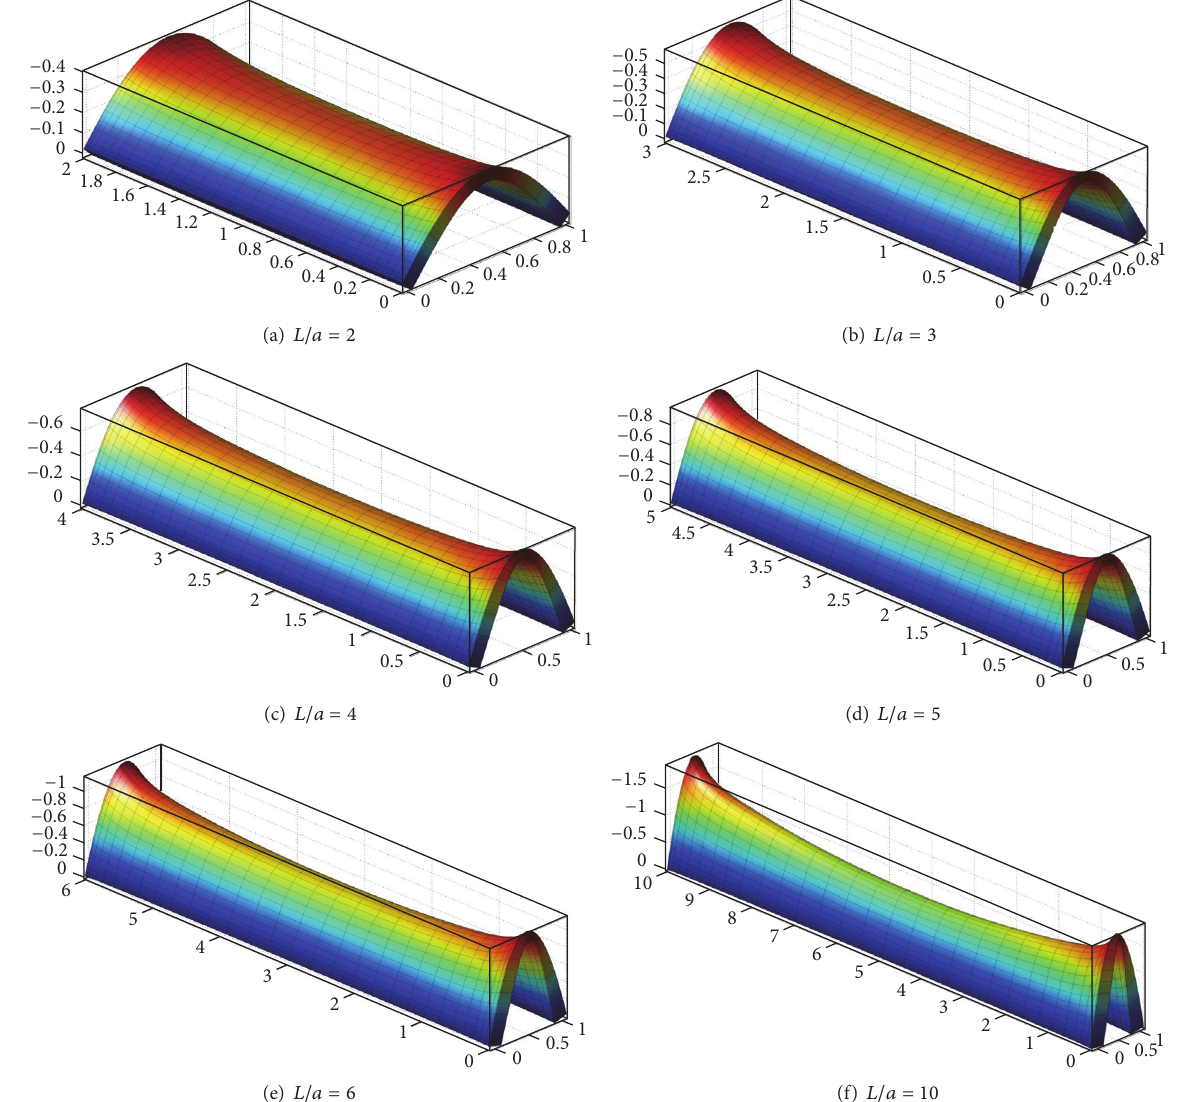
Figure 5: First vibration mode for the 𝑎/ℎ = 100 one-layered FGM plate with 𝑝 = 0.5 : 2D GDQ solution and edge effects versus the length of the simply supported